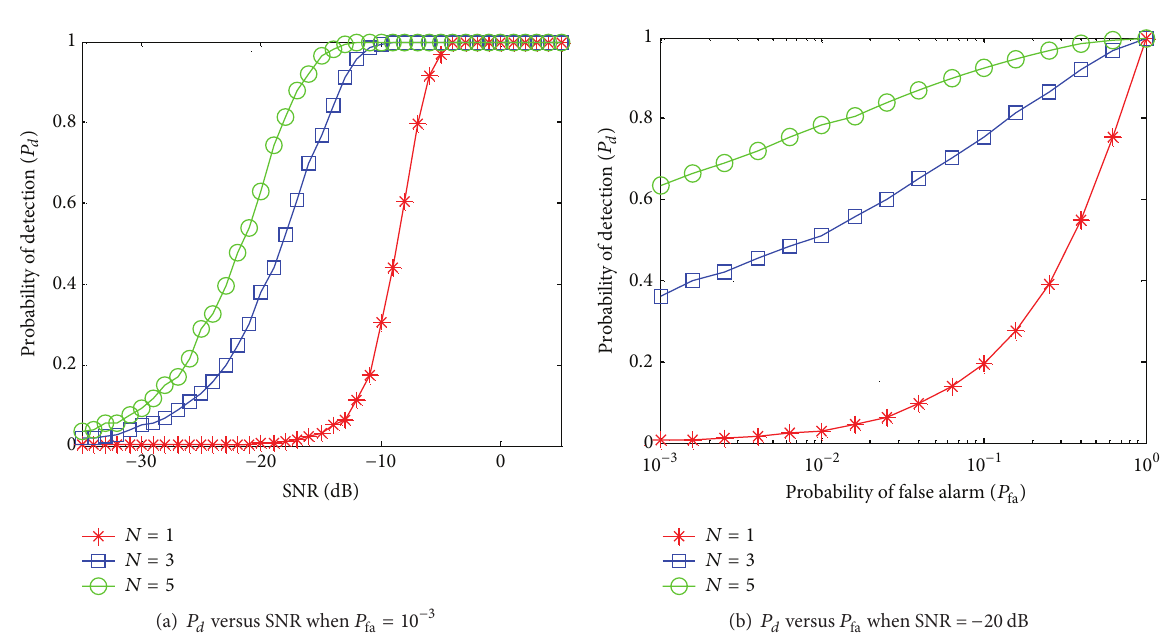
Figure 4: Effect of the path number on the detection performance.